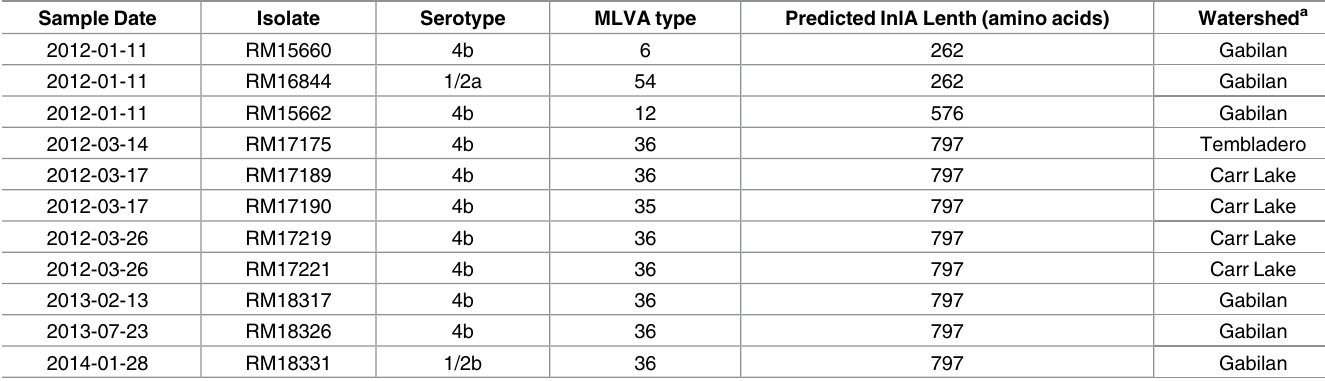
Table 2. Sample and isolate information for aberrantInlA